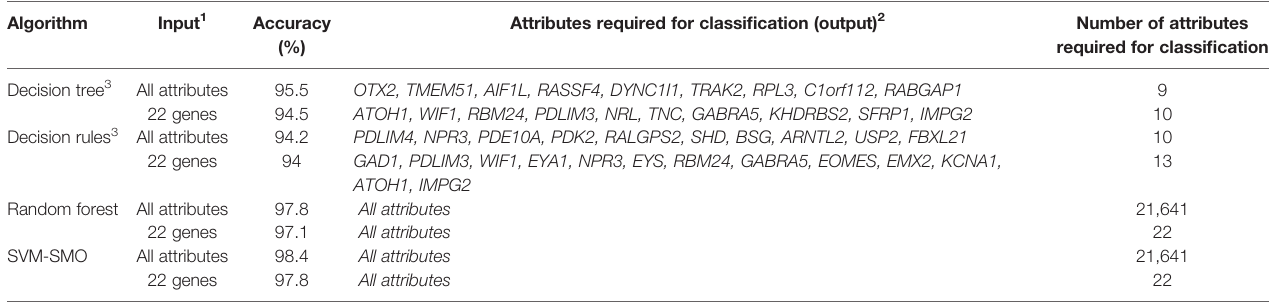
TABLE 1 | The accuracies of the sets of attributes selected for classi fi cation by each algorithm, based on the GSE85217 dataset (n = 763 MB samples). Algorithm Input 1 Accuracy (%)